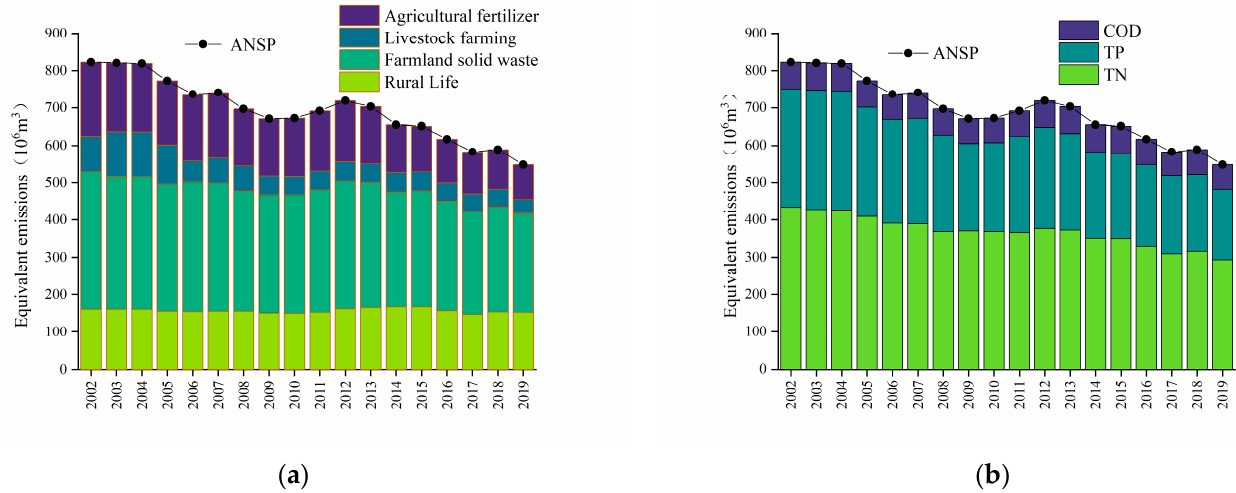
Figure 2. ( a ) ANSP and its pollution sources; ( b ) ANSP and its pollutants.